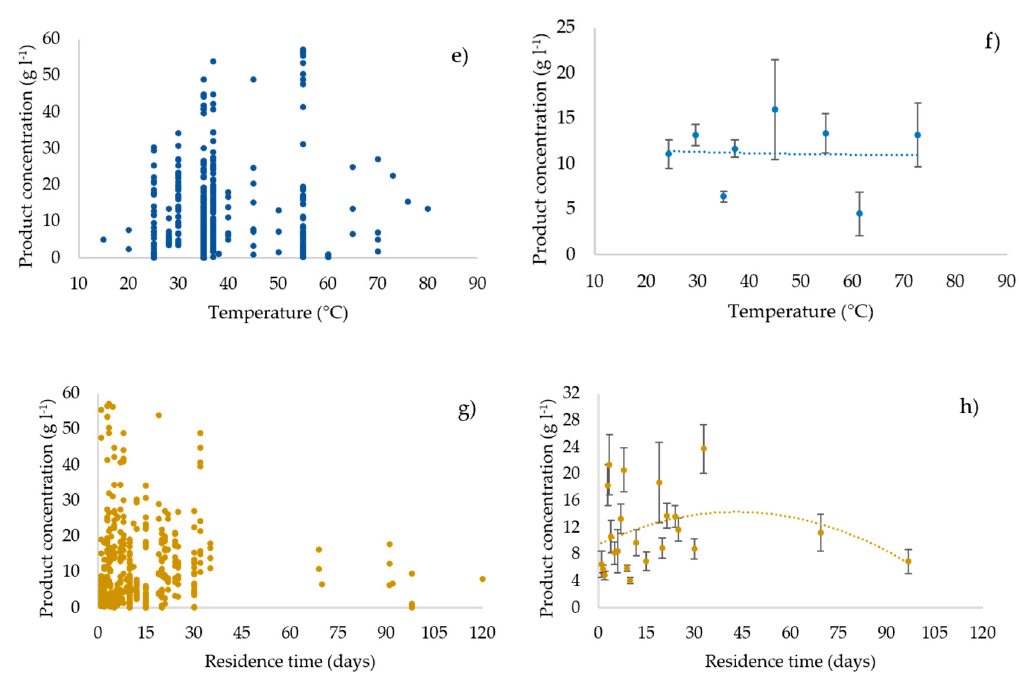
Processes 2020 , 8 , x FOR PEER REVIEW